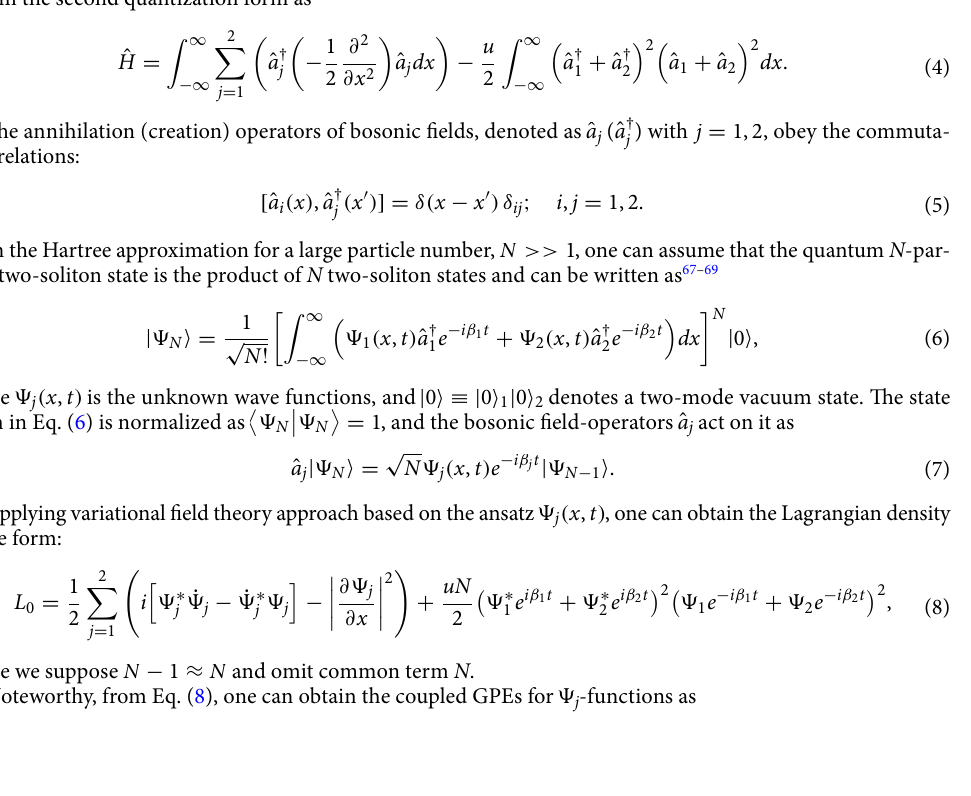
Figure 1. Sketch of the probability density distribution projection of the 3D coupled condensates trapped in a double-well (dashed green curve) and harmonic (dashed magenda curve) potentials, respectively. Shadow regions display 1D condensate wave packets projections; they represent a secant-shape in X -direction and Gaussian-shape in the transverse